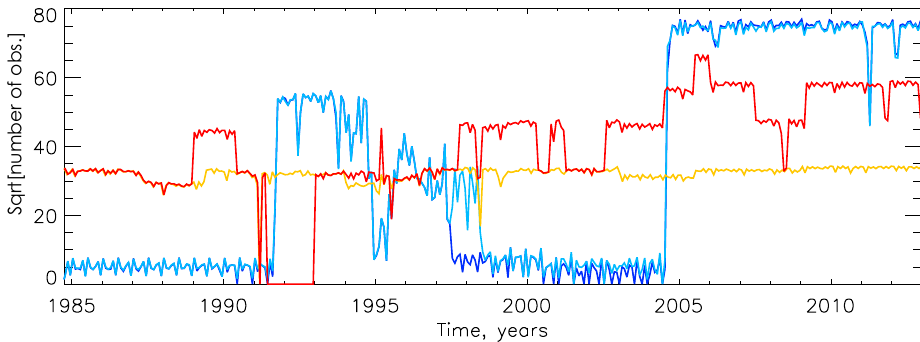
Figure A2. The square root of the latitude-weighted number of observations at 1hPa between 20 ◦ S and 20 ◦ N in each of the composites: GOZCARDS (blue), SWOOSH (light blue), SBUV-MER (yellow), and SBUV-MOD (red).